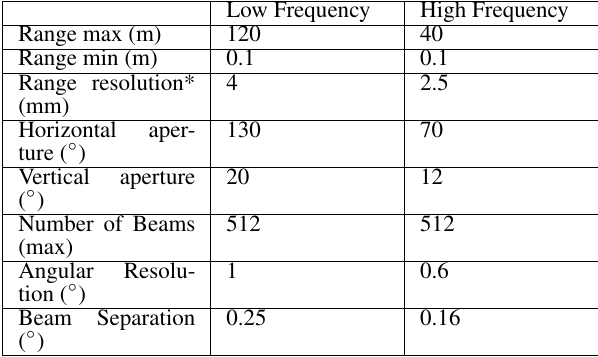
Table 2. Oculus Sonar M750d specification (* indicates parameter is dependent on